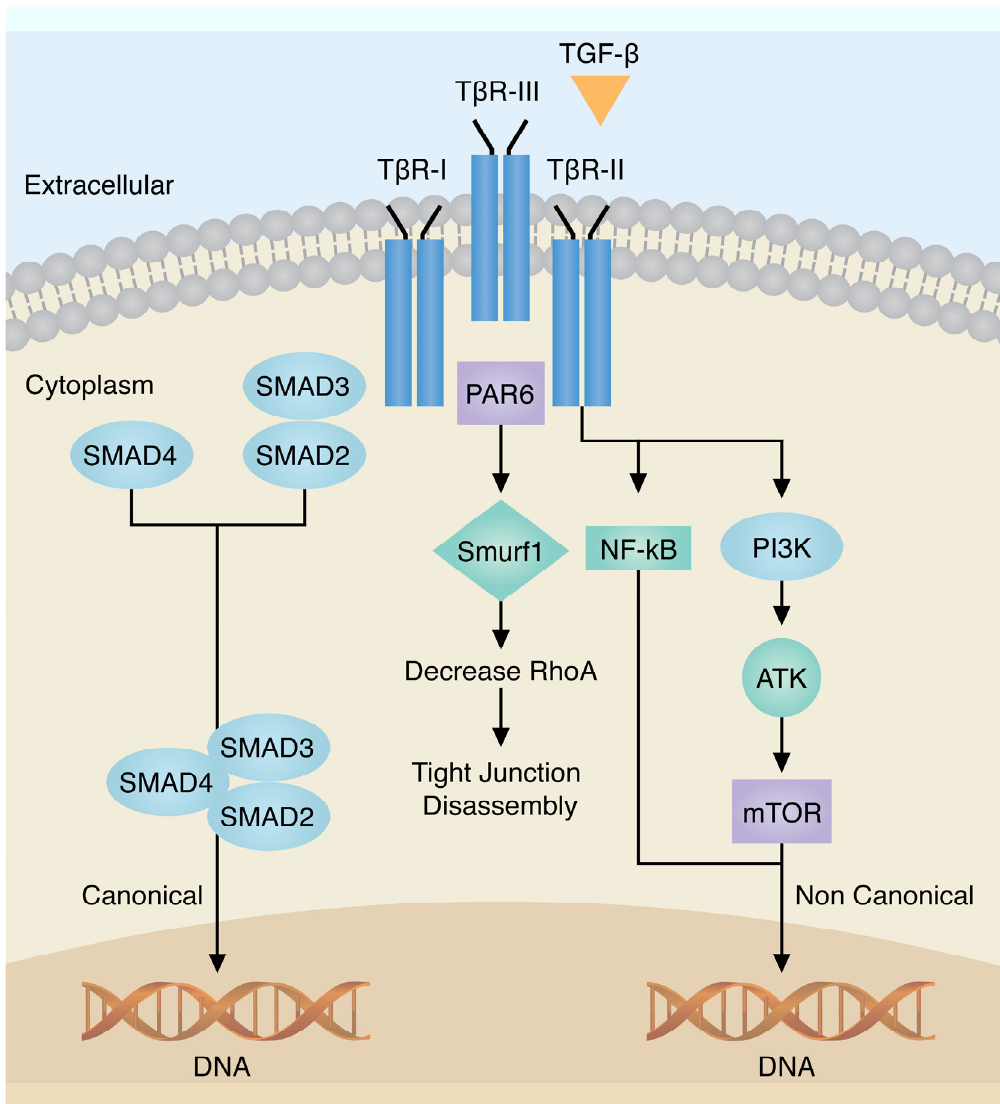
Figure 2. Transmembrane signaling by TGF- β . Canonical TGF binds to T β R-III, with recruitment of T β R-I, resulting in activation of Smad 3/2 and 4 translocate to the nucleus to regulate TGF- β genes ( left ); The non-canonical TGF binds to T β R-II (or III with subsequent binding of II) through Smad-independent pathway including Par-6, NF-kB, PI3K is shown ( right ). Adapted from Taylor et al.